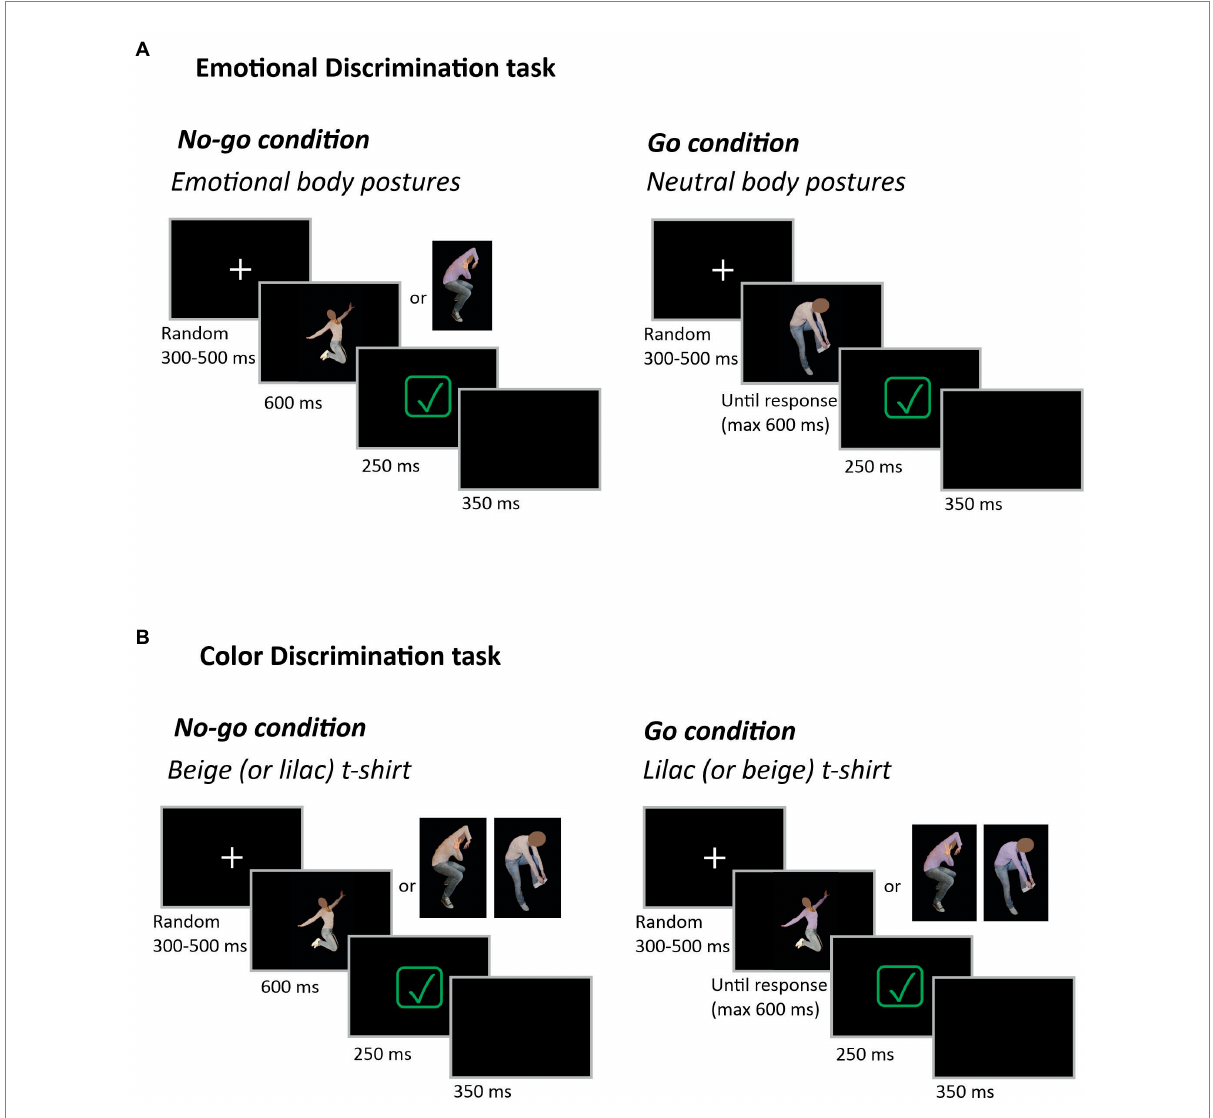
FIGURE 3 Experimental Design. Emotional Discrimination task (A). Each trial started with a fixation cross at the center of the screen. After a random delay of 300–500 ms, the picture of a body posture, either fearful, happy, or neutral, was shown. Participants were instructed to respond as quickly and accurately as possible to neutral stimuli (Go-signal, 67%) by pressing the mouse’s left button with their right index finger. Differently, they had to refrain from responding when happy and fearful postures were presented (No-go signal, 33%). Visual feedback, i.e., a green checkmark, signaled correct trials. The inter-trial interval was 350 ms. Color Discrimination task (B) . The sequence of events was the same as in (A) , except that participants were instructed to respond or not according to the color of the actor/actress’ t-shirt. To avoid a color bias, one-half of the participants had to respond to the appearance of a beige t-shirt, withholding it when a lilac t-shirt was shown, and vice versa for the other half of participants. We used stimuli from Mazzoni et al. (2022), which can be freely published. See the online version of the present article for colored